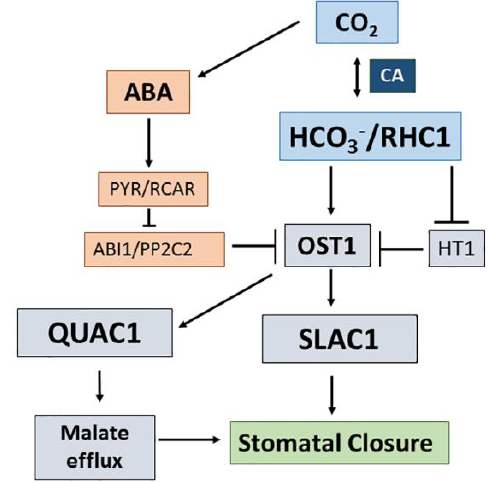
Figure 3. Mechanisms of stomatal closure induced by high CO 2 or HCO 3 − concentrations according to [183,184]. CA, carbonic anhydrase; ABA, abscisic acid; ABA receptor, PYR/RCAR, Pyrabactin Resistance (PYR) Regulator Component of ABA Receptor (RCAR); ABI1/PP2C2, Abscisic acid Insensitive Protein Phosphates C2; RHC1 Resistant to High CO2, MATE-type transporter specific activated by HCO 3 − ; HT1, High Leaf Temperature kinase; OST1, Open Stomata1 protein kinase; SLAC1, Slow Anion Channel1; QUAC1, Quick Anion Channel1.